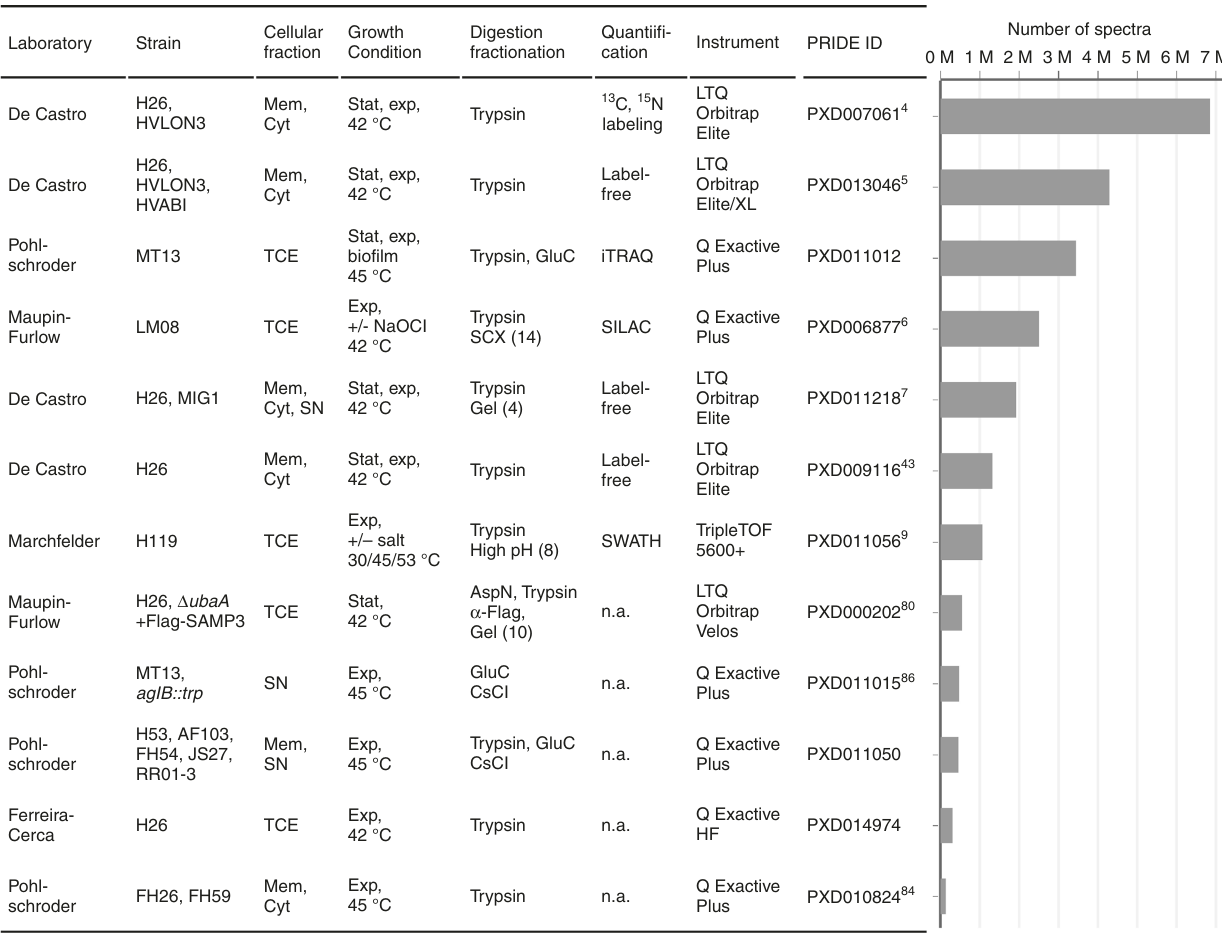
Fig. 1 Summary of ArcPP datasets comprising a total of more than 23 million spectra. A diverse array of MS datasets for H. volcanii has been compiled for the initial reanalysis by the ArcPP. For each dataset, strains (separated by comma), cellular fractions (Mem, membrane; Cyt, cytosol; SN, culture supernatant, TCE, total cell extract), growth conditions (stat, stationary; exp, exponential growth phase), enzyme(s) used for protein digestion, and fractionation methods on peptide (SCX, strong cation exchange chromatography; high pH, high pH reversed-phase chromatography) or protein level (gel, SDS-PAGE; CsCl, CsCl gradient) with the number of fractions indicated in parentheses, quanti fi cation methods (iTRAQ, isobaric tags for relative